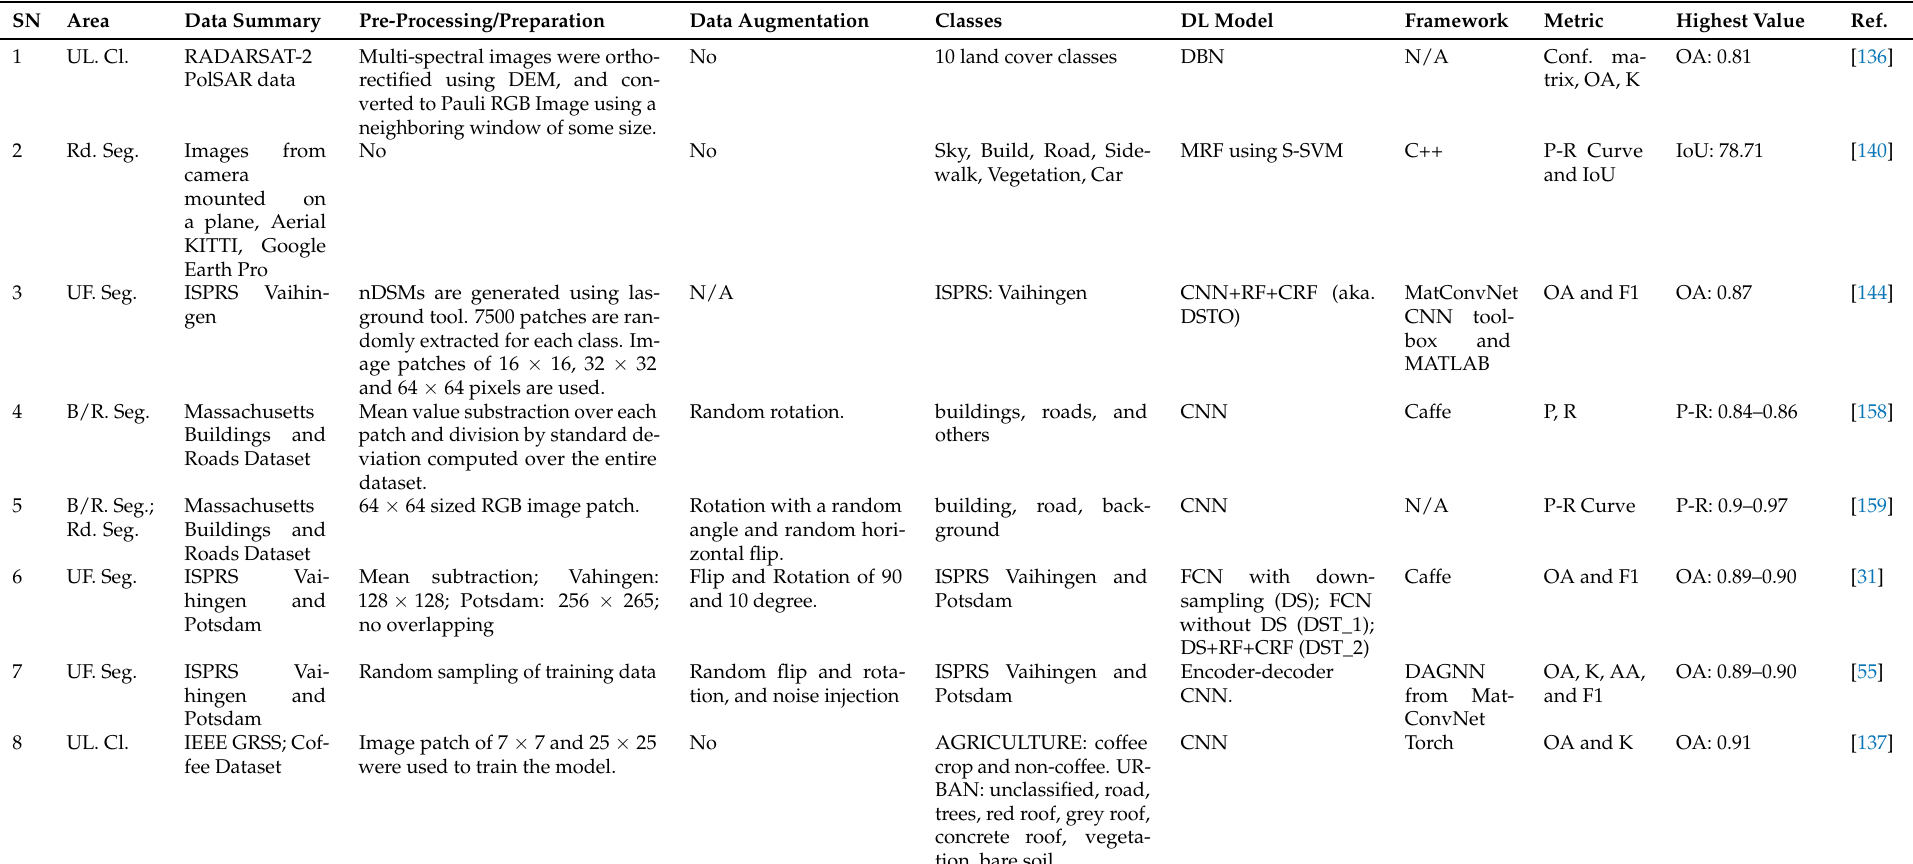
Table A1. Deep Learning-Based Semantic Segmentation for Urban LULC and Methods